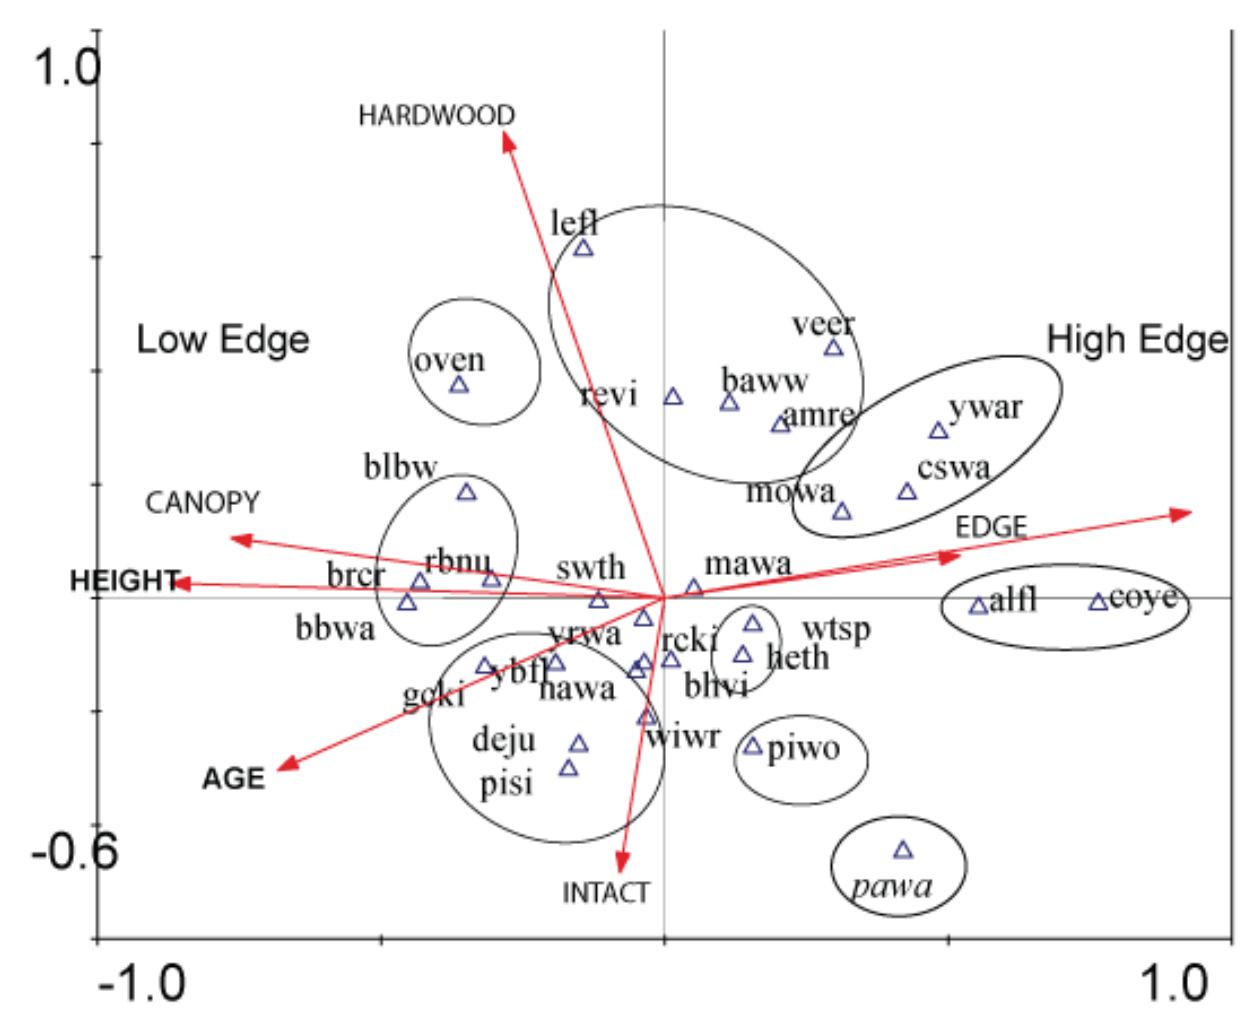
Fig. 2. Simple correlations of environmental variables with species occurrence. Arrows show positive correlations only, and points in proximity correspond to species often occurring together. Length of the arrow represents the strength of the association with overall community structure. Species close to the origin show no strong discrimination patterns for the measured environmental variables. Species codes are defined in Table